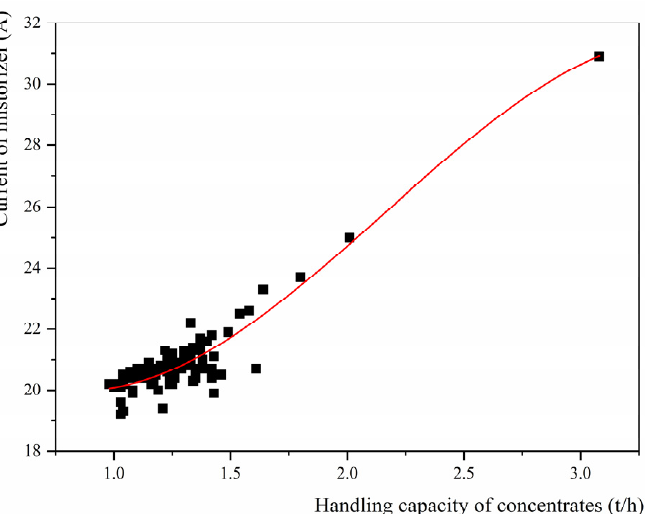
Figure 2. Diagram of the relationship between the current of mistorizer and the handling capacity of the concentrates.